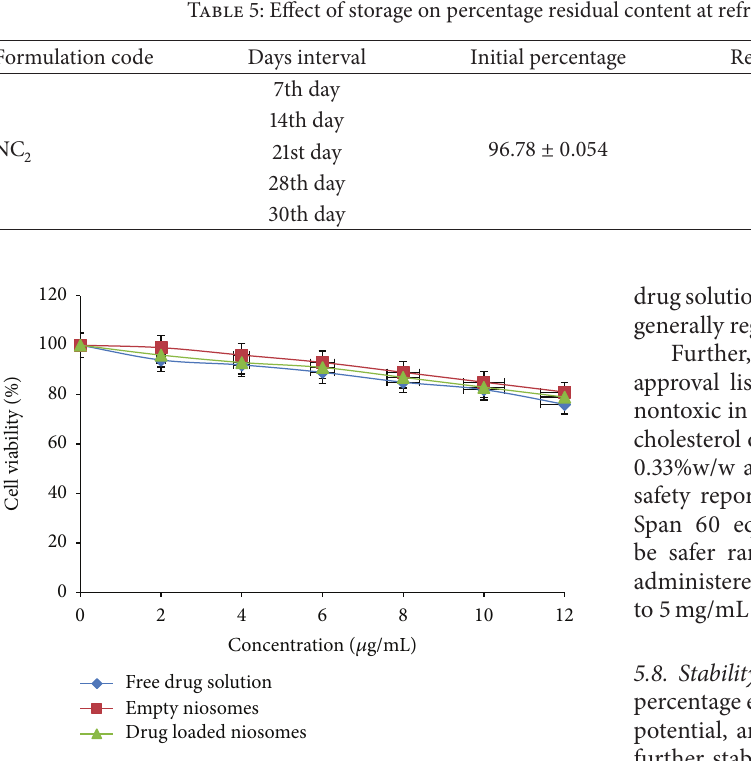
Figure 7: Cell viability study of free drug solution; empty niosomes; drug loaded niosomes on A549 cell lines ( 𝑛 = 3